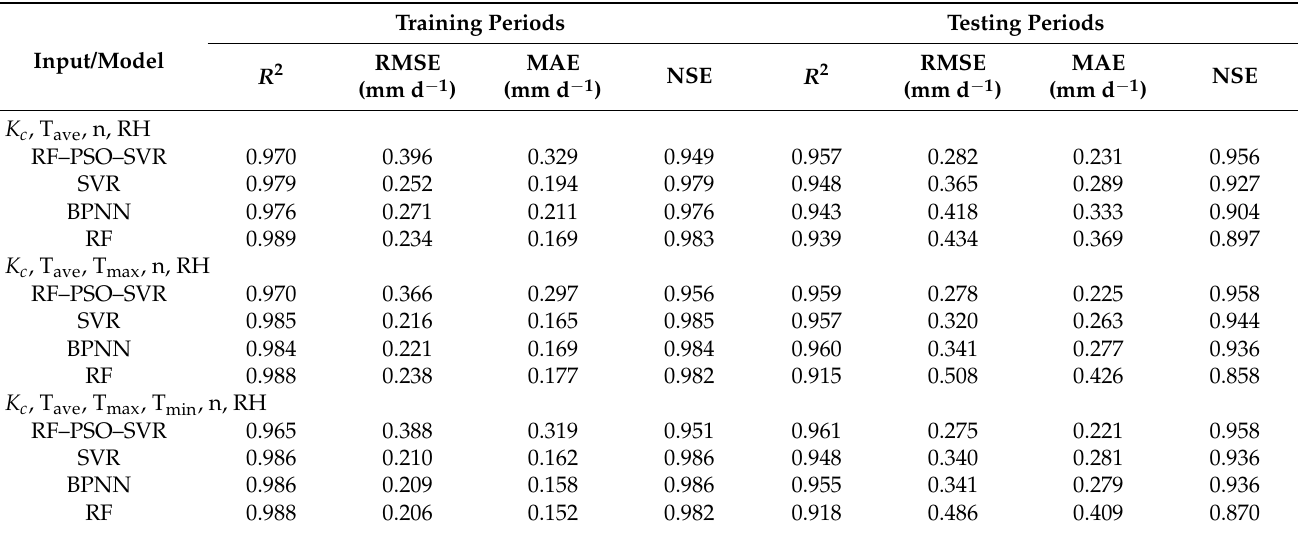
Table 3. Statistical performance of hybrid RF–SVR–PSO model, standalone SVR model, BPNN model and RF model with three different variables input for training and testing